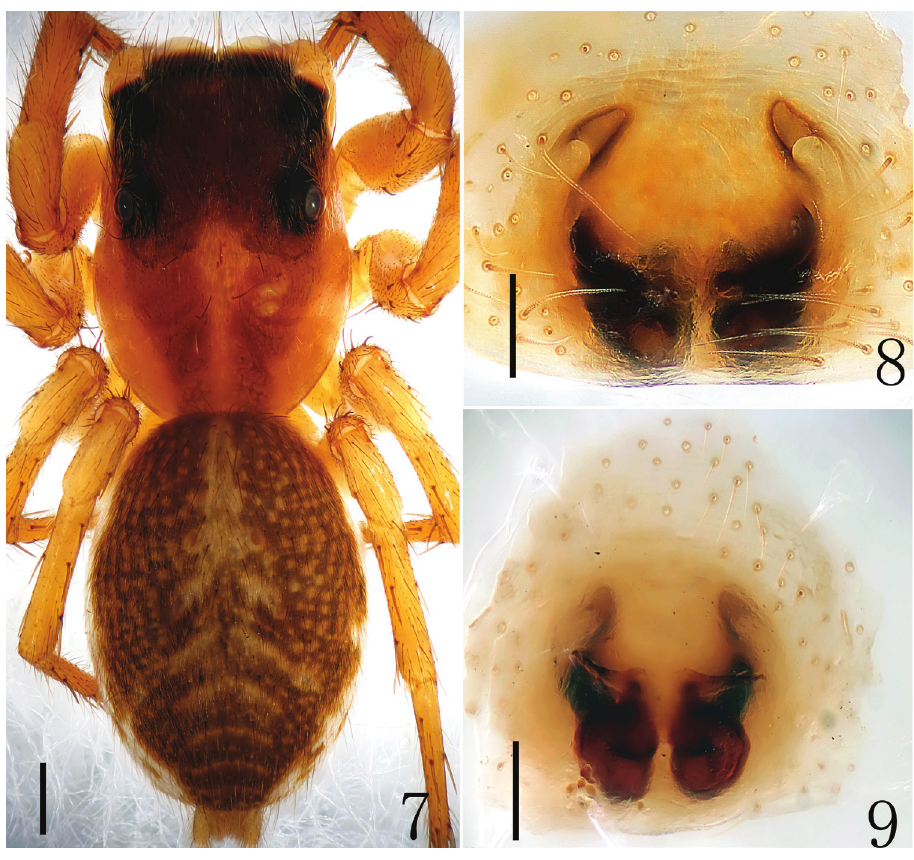
Figures 7–9. Yaginumaella lushuiensis sp. n. 7 female body, dorsal view 8 epigyne, ventral view 9 vulva, dorsal view. Scale bars: ( 7 ) 0.5 mm; ( 8, 9 ) 0.1 mm.